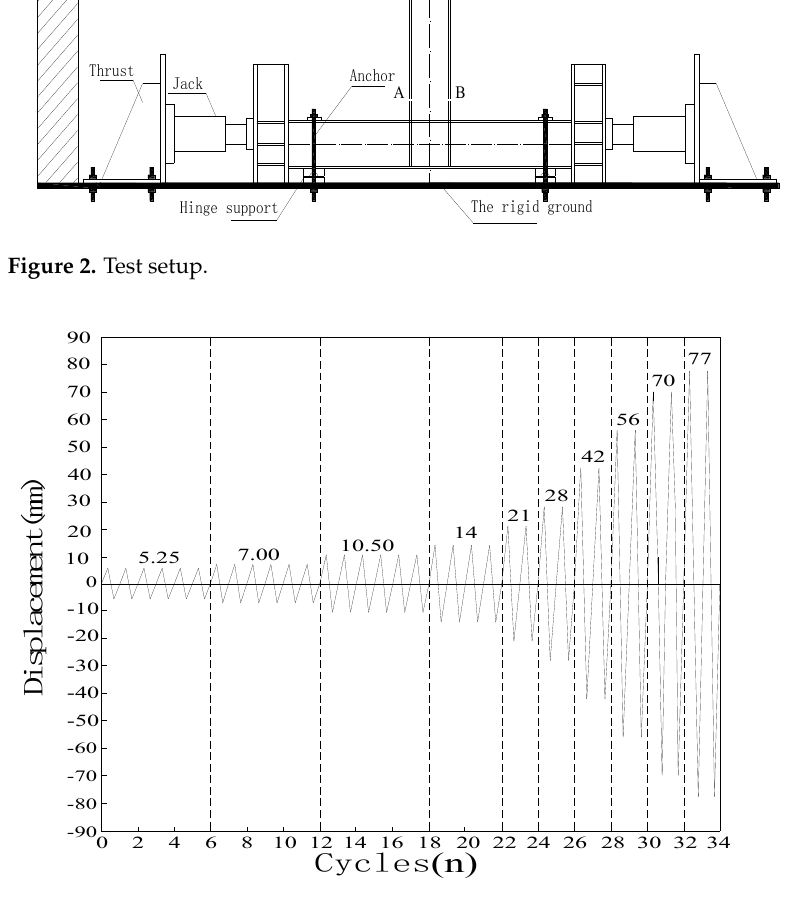
Figure 3. Loading method .